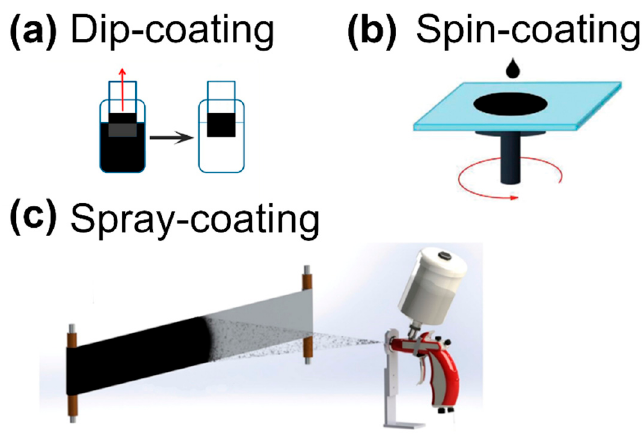
Figure 3. Methods to transform CNT dispersions into coatings and self-standing films without employing porous membranes or conductive substrates. ( a ) Dip-coating reproduced with permission from [94], Copyright the American Chemical Society (2012); ( b ) spin-coating reproduced with permission from [102], Copyright The Authors (2016); ( c ) spray-coating reproduced with permission from [103], Copyright AIP Publishing Ltd. (2014).